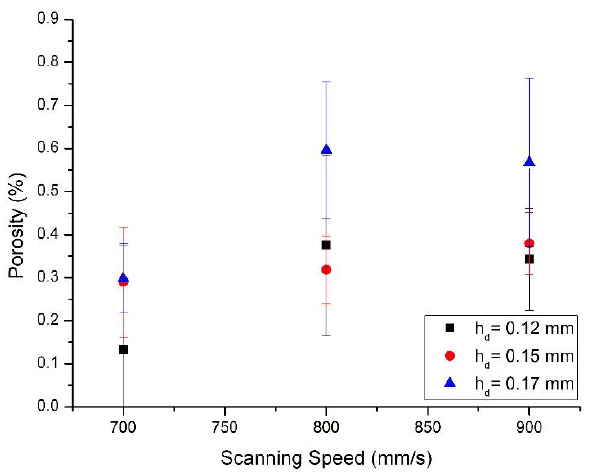
Figure 2. Porosity versus scanning speed graph for the F357 powder processed using 30 µm as layer thickness, 195 W as laser power, and varying hatching distance.